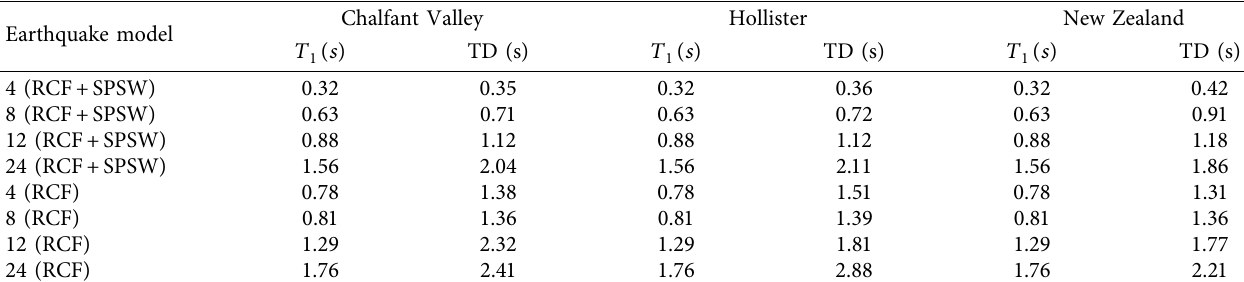
Table 6: Te frst-mode period of vibration and period of damaged of the models under Group I.